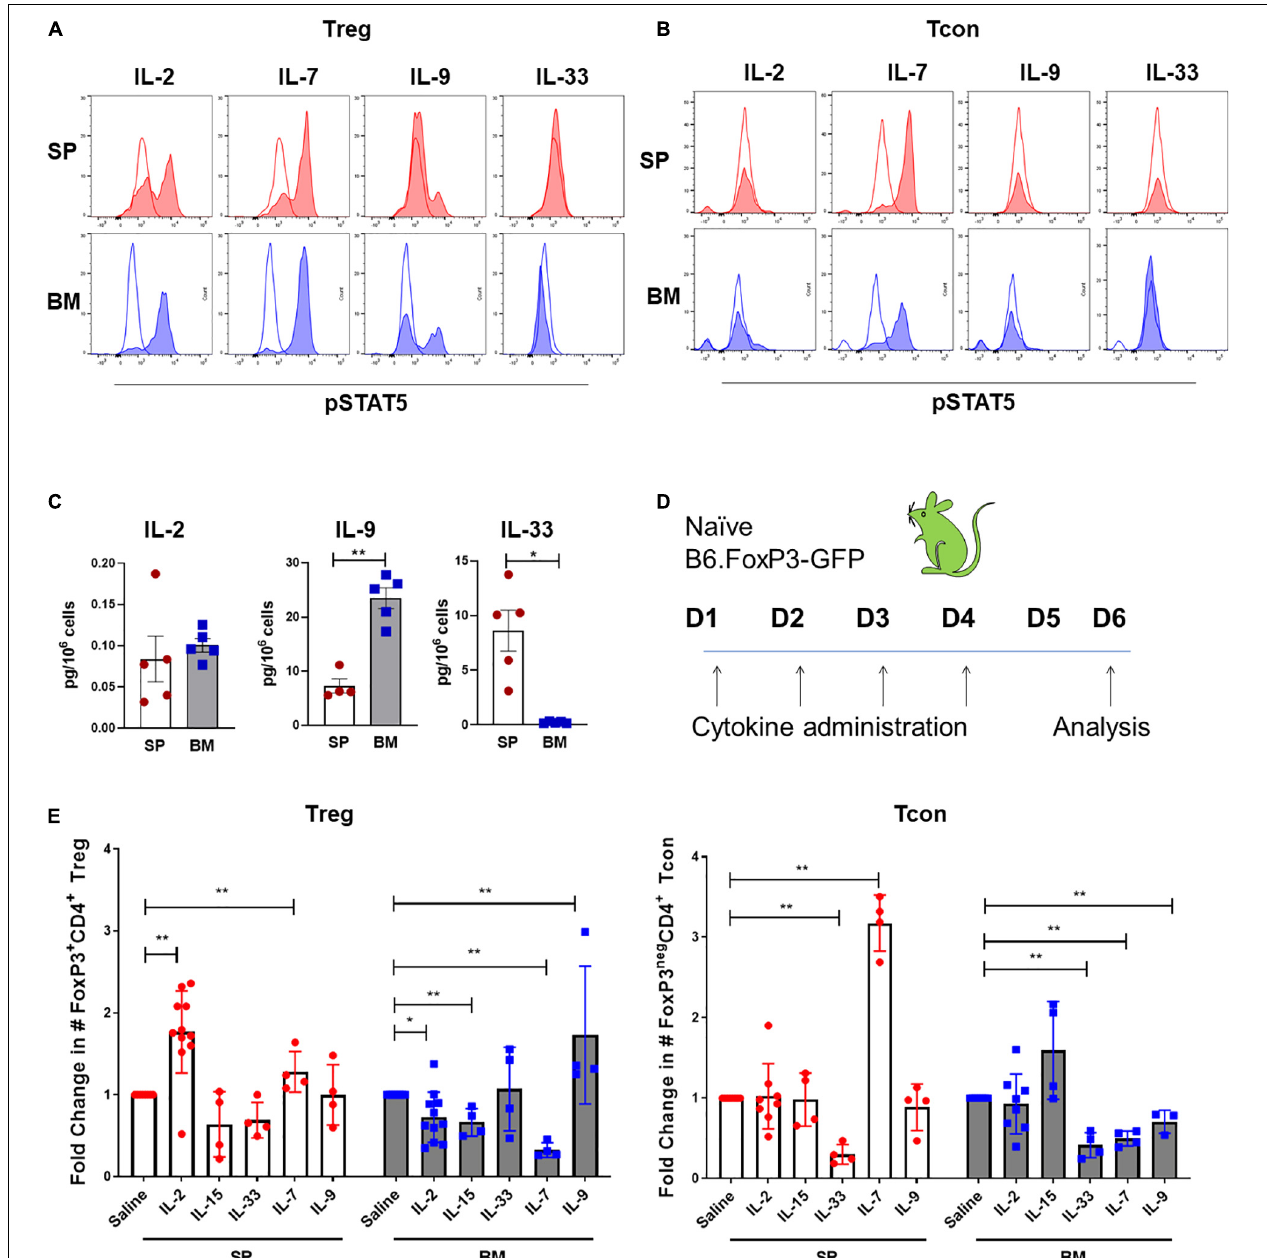
FIGURE 6 | BM-Treg exhibit unique cytokine signaling requirements. (A) MFI of STAT5 phosphorylation (pSTAT5) in CD4 + FoxP3 + Treg isolated from either the BM or SP following in vitro cytokine stimulation. (B) MFI of pSTAT5 in CD4 + FoxP3 neg T cells isolated from either the BM or SP following in vitro cytokine stimulation. (C) Quantification of in vivo concentrations of IL-2, IL-9, and IL-33 in the BM and SP of naïve WT mice. (D,E) Naïve B6.FoxP3-GFP mice were administered with recombinant cytokines (IL-2, IL-7, IL-15, and IL-33) or saline for 4 days prior to analysis of Treg and Tcon populations in the SP and BM. (D) Schema of cytokine administration. (E) Fold change in the absolute number of FoxP3 + Treg and CD4 + FoxP3 neg T cells in the BM and SP following cytokine administration. Data are shown as mean ± SEM, and statistical significance was determined using paired t test (* P < 0.05; ** P < 0.01). Statistical analyses were performed using GraphPad Prism version 6.01 software. pSTAT5, STAT5 phosphorylation; WT, wild